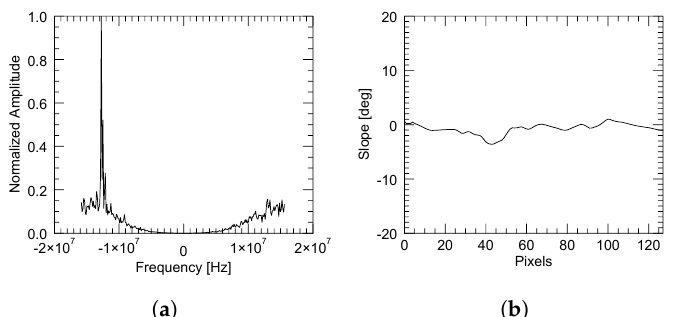
Figure 13. Computed normalized power spectrum ( a ) with the adaptive method in a region with an almost constant slope ( b ). A high SNR allows a clear identification of the peak (coherent